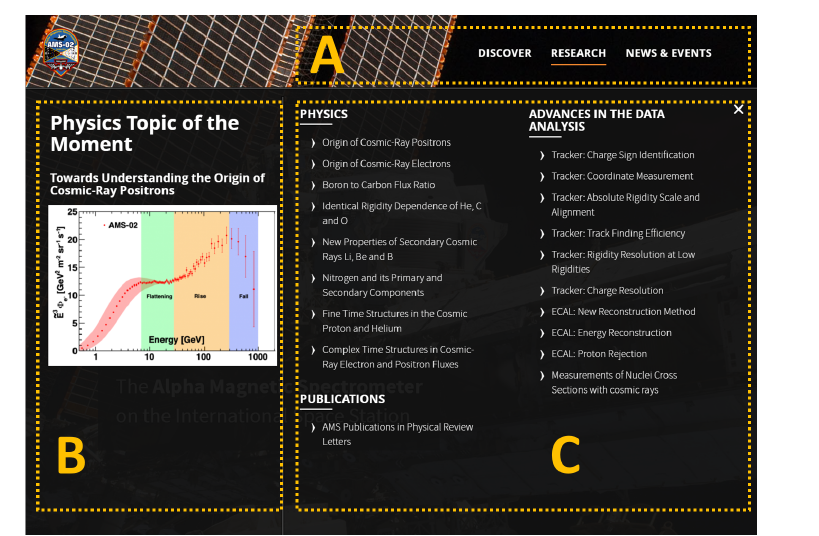
Figure 2. Layout of the Mega Menu. The menu is divided into three parts: (a) the top menu bar fixed to the top of the page. The menu panel is expanded by clicking on the menu bar. (b) the highlight area to promote featured contents and (c) the main menu area with all the items included under the selected